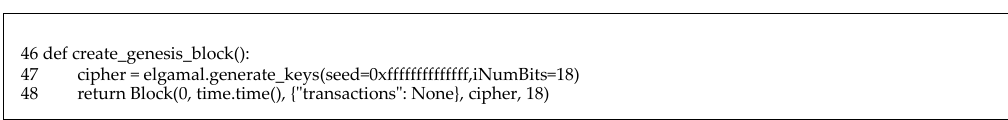
Figure 10. Implementation of creating a genesis block.